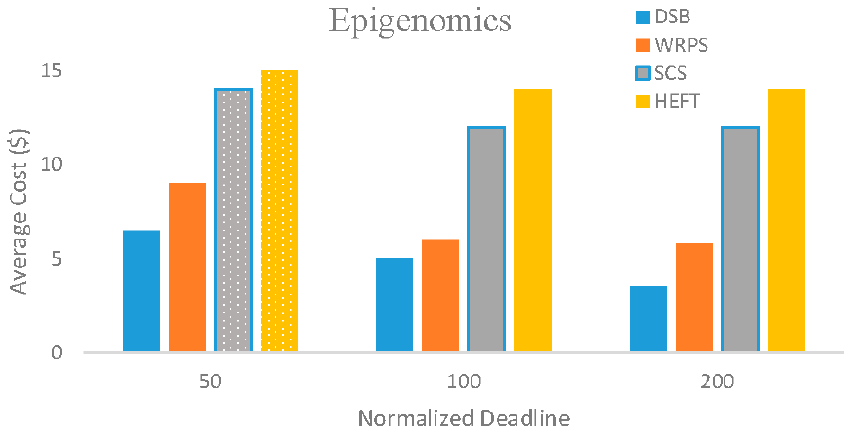
Figure 4. Average cost of CyberShake under varied normalized deadline.